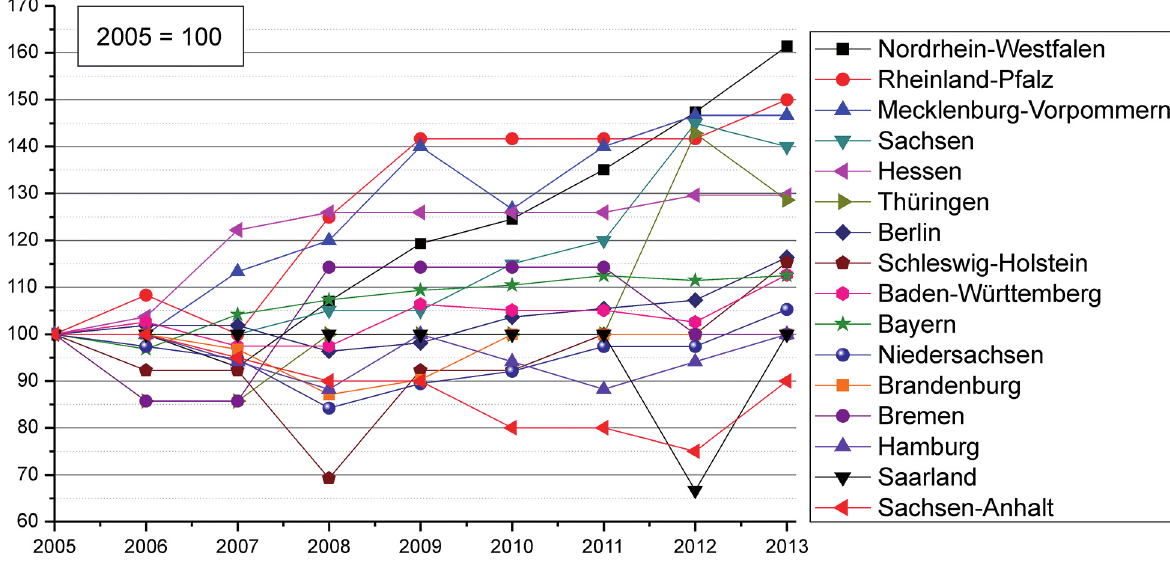
Fig. 8. Biotech companies per 10,000 firms and their structure in 2011 Source: own calculations based on the Internet portal